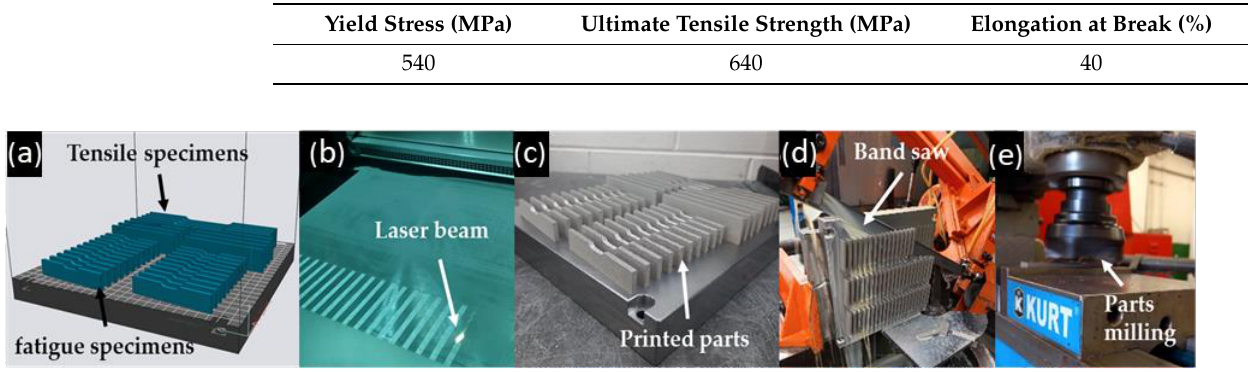
Table 3. 316L AM mechanical proprieties measured by the supplier (horizontal mode).